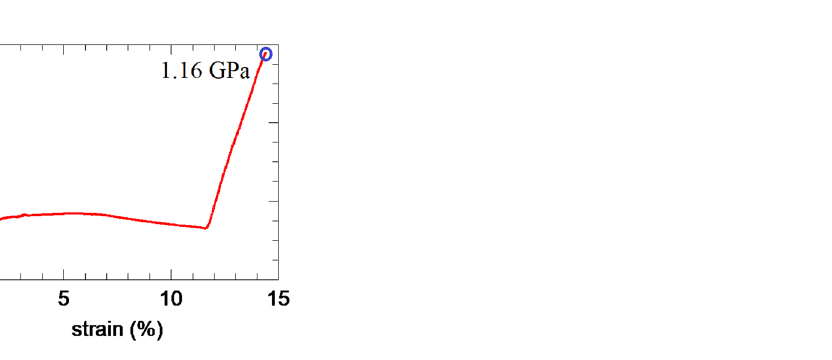
Figure 4. Typical bending strength curve at 1800 °C measured on the TiB 2 -BC sample obtained by